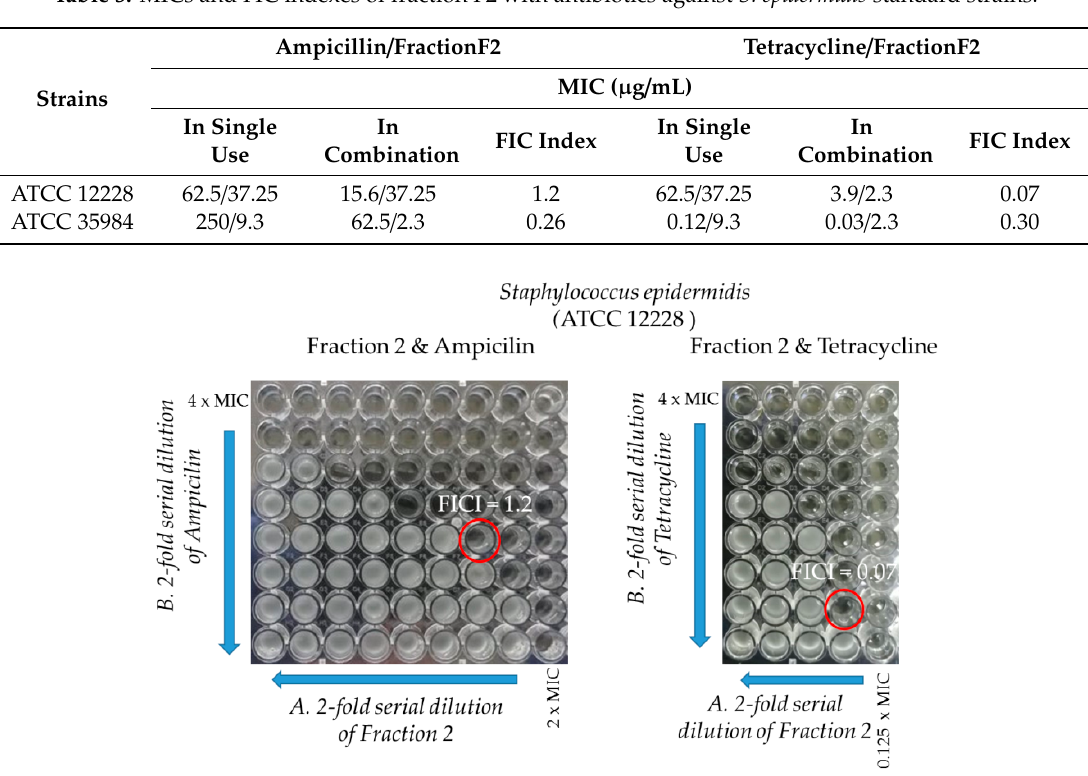
Figure 6. Effect of the combination of fraction F2 with antibiotics: ampicillin (left) and tetracycline (right) against certified S. epidermidis ATCC 12228. FICI arrows indicate the direction of the decreasing concentration. Fraction F2 MIC = 37.25 μ g/mL.